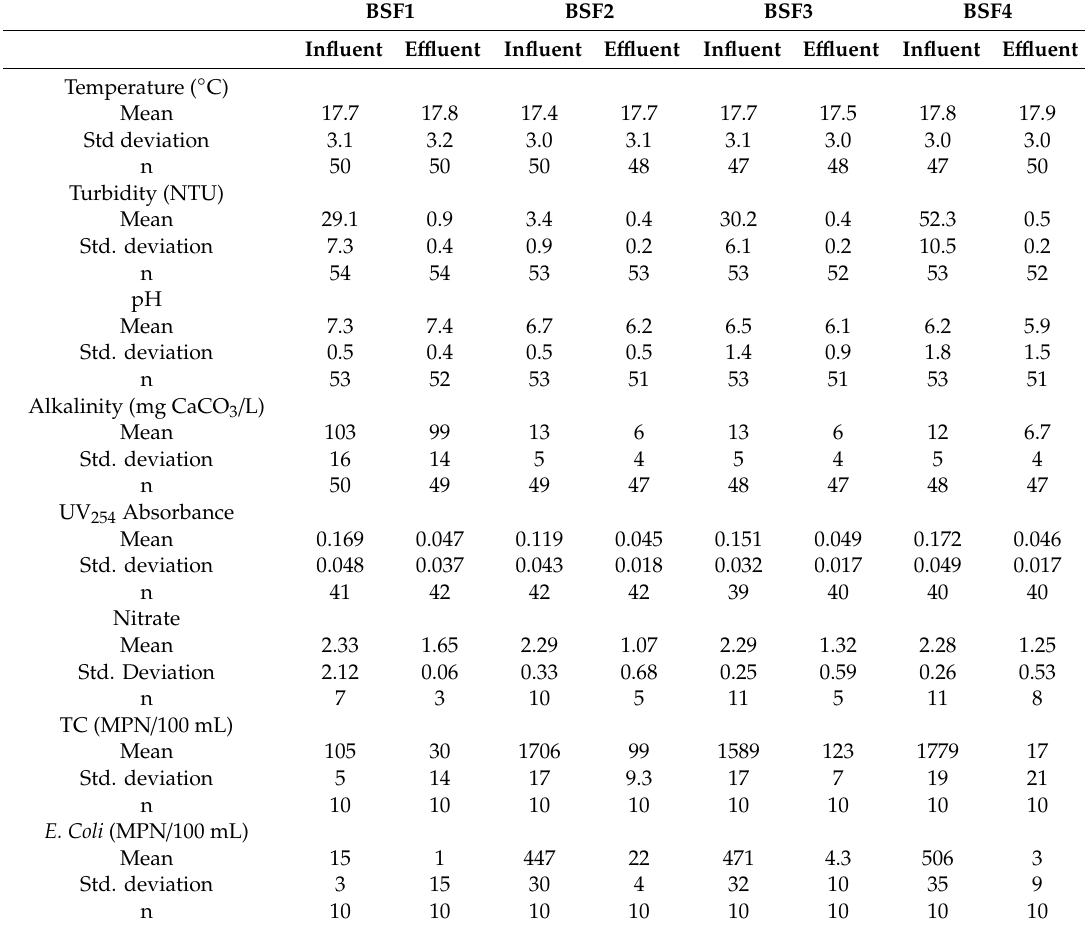
Table 2. Summary of influent and e ffl uent water quality variables measured in the BSF